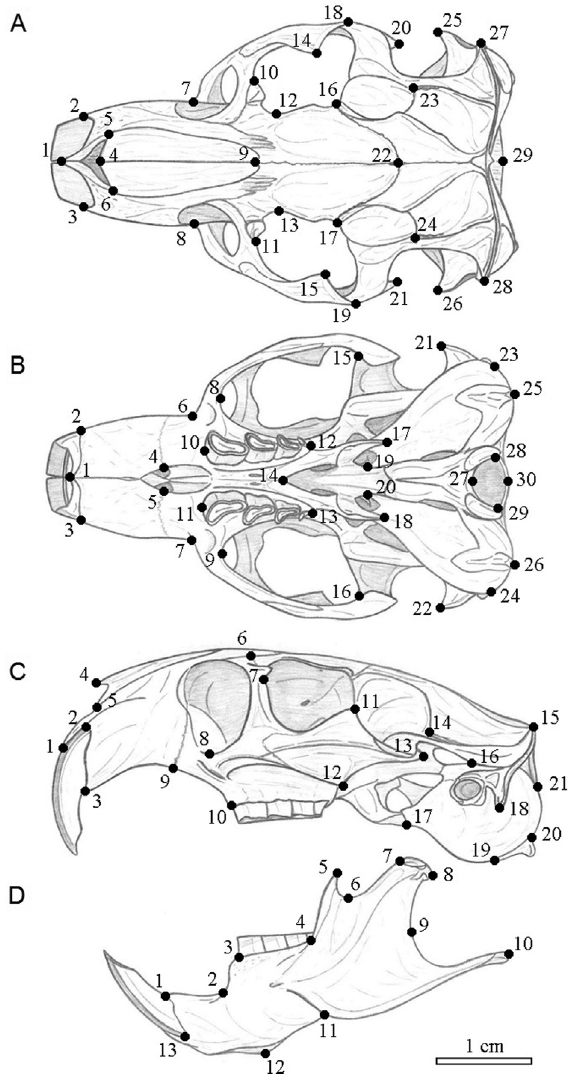
Figure 2 - Landmarks location on skull of Ctenomys for dorsal (A), ven- tral(B),andlateral(C)viewsofthecraniumandlateralviewofthemandi- ble (D). See Table S1 for anatomical description of each